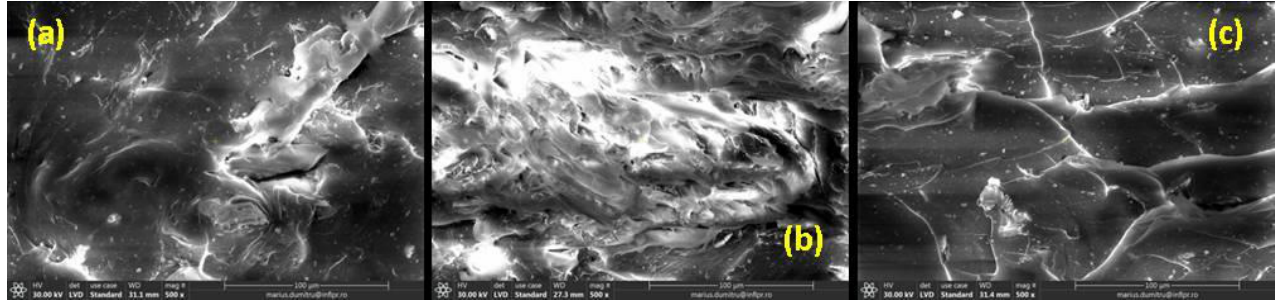
Figure 8. SEM micrographs of non-irradiated NR-C sample ( a ) and irradiated at 150 kGy ( b ) and